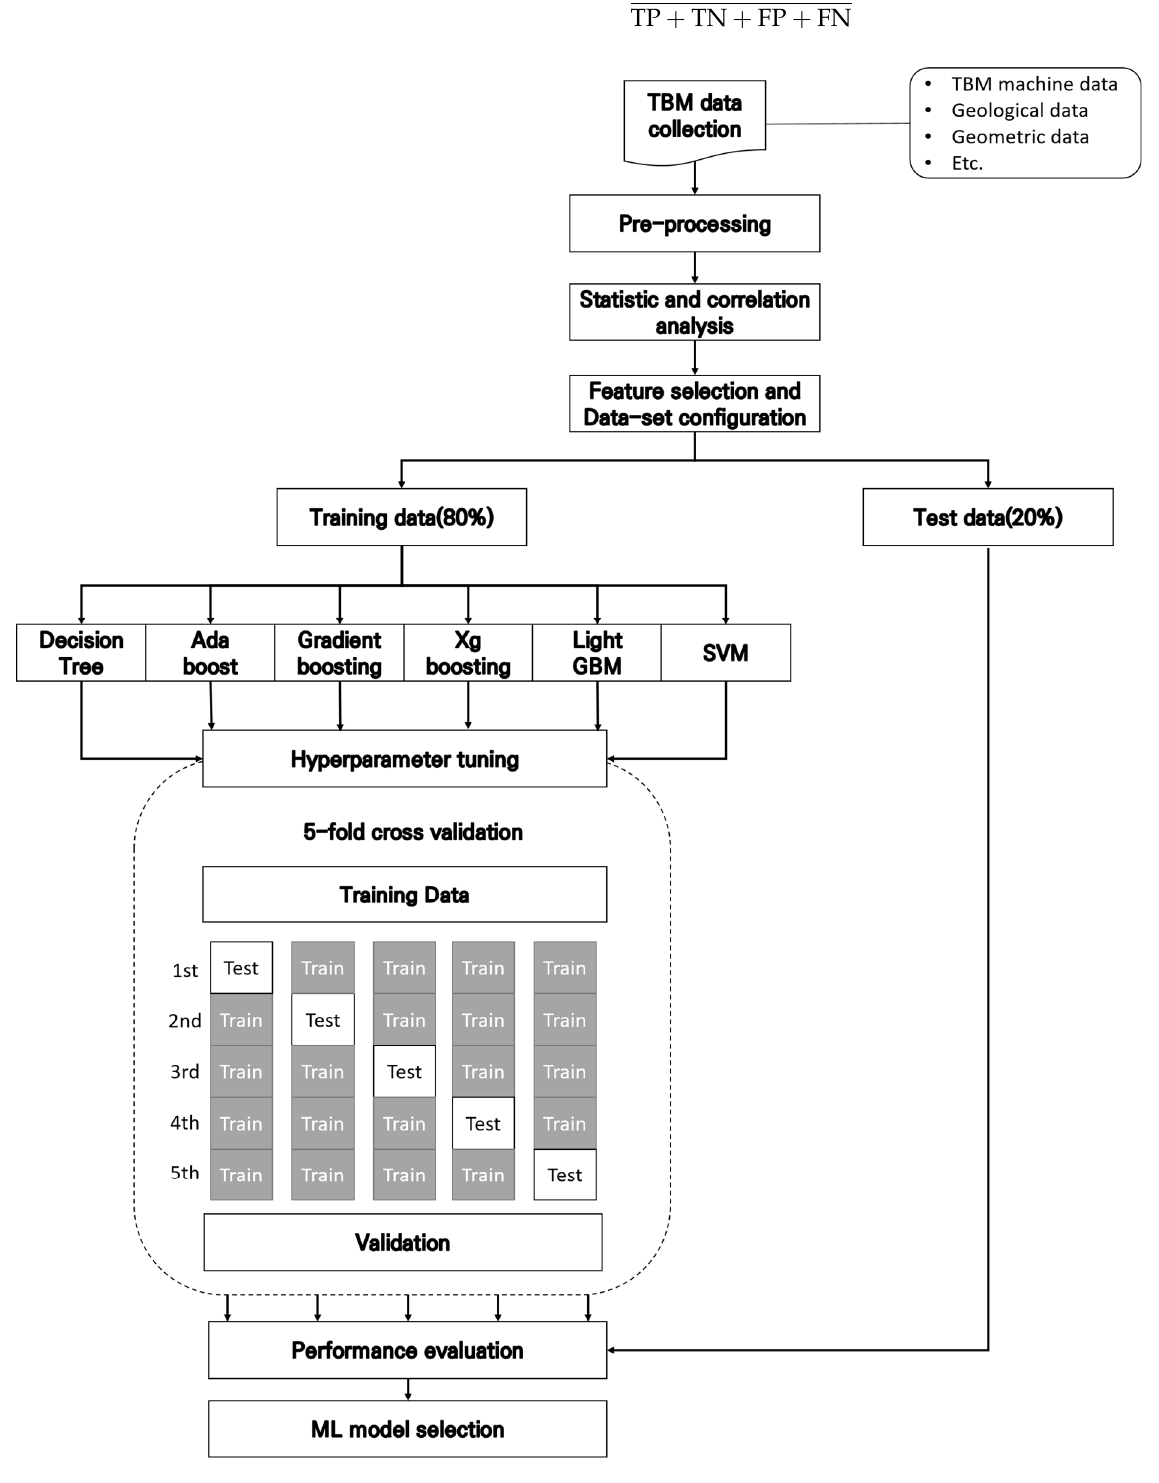
Figure 6. Flowchart of machine learning model procedure for class prediction. Table 5. Confusion matrix of classification.